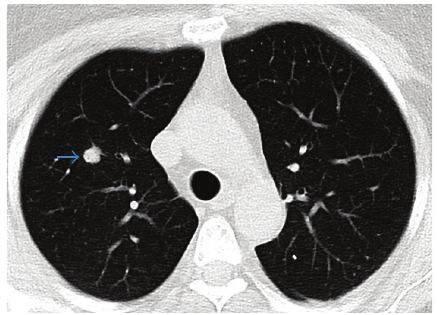
Figure 6: Thorax CT showing lesion in the right